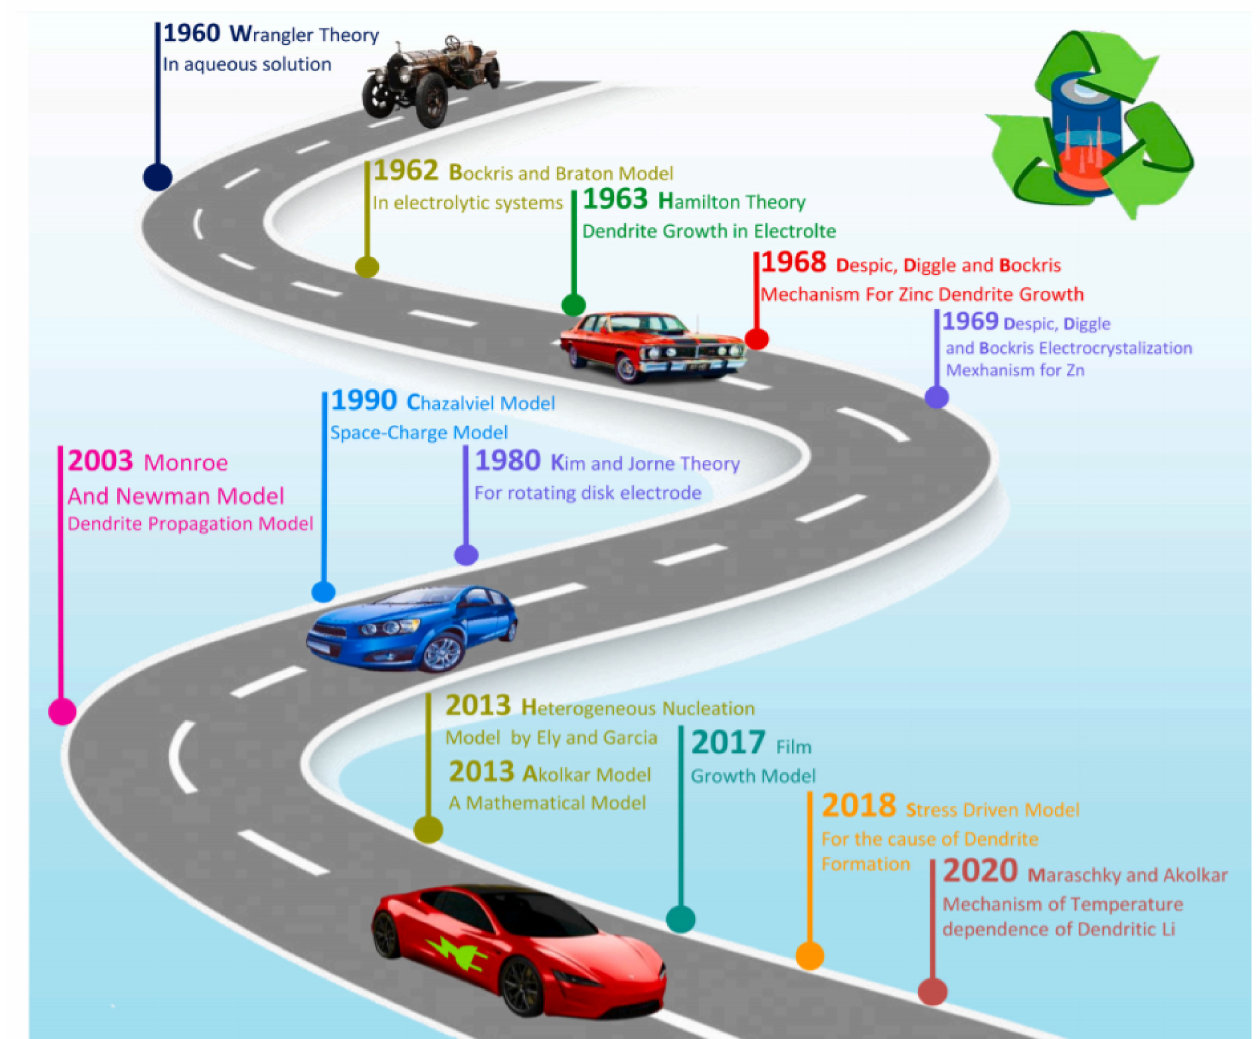
Figure 16. Roadmap of dendrite growth models, principles, and theories from 1960 to 2020 (adapted with permission from [192], Nano energy, Elsevier,